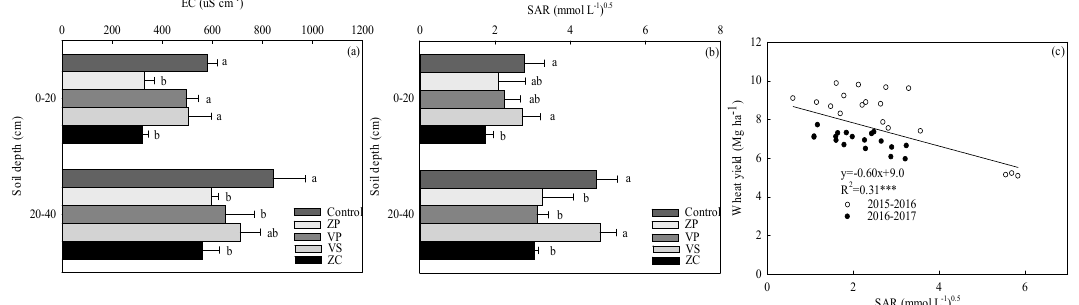
Figure 3. Treatment effect on soil electrical conductivity (EC) ( a ) and sodium adsorption ratio (SAR) ( b ) at soil depths of 0–20 and 20–40 cm after wheat harvest in 2016–2017, and the relationship ( c ) between wheat yield (Mg ha − 1 ) and soil SAR (0–20 cm soil layer). Values for the same year followed by the same letter are not significantly different from each other ( p < 0.05). *** Significant at p <